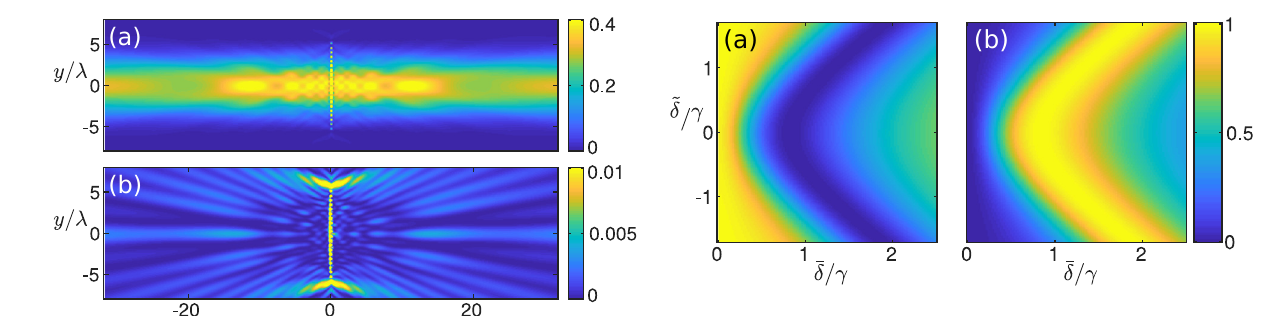
Figure 6: PT symmetry in polarization conversion. (a) y component ⃒⃒⃒⃒⃒ ⃒⃒⃒⃒⃒ ⃒⃒⃒⃒⃒ ⃒⃒⃒⃒⃒ 2 + 2 of total outgoing (transmitted and re fl ected) light E (+) E (−) y y leaving the array as a function of ˜ δ and δ , and (b) outgoing x ⃒⃒⃒⃒ ⃒⃒⃒⃒ ⃒⃒⃒⃒ ⃒⃒⃒⃒ 2 + 2 , for symmetric y polarized plane wave polarized light E (+) E (−) x x incident on 20 × 20 lattice with d = 0.54 λ . At the EP at δ (cid:1) υ I , solutionsemergeforwhichtotalpolarizationconversionispossible. EP occurs at ˜ δ (cid:1) 0 and δ (cid:1) υ I (cid:1) 0 . 83 γ